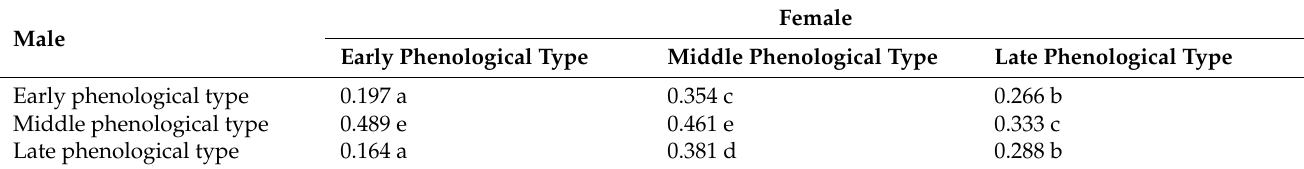
Table 4. Average synchronization index at different flowering types.